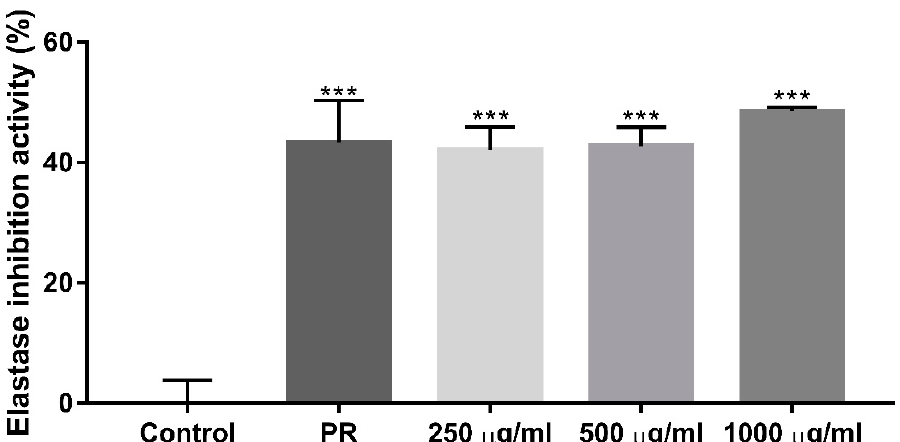
Figure 6. Percentage of elastase inhibition activity according to PR (positive control) and 250, 500, and 1000 μ g/mL of EverCTP TM (NEWTREE Co., Ltd., Seoul, Korea) treatment. The treatment increased elastase inhibition activity as much as PR. *** p < 0.005, independent samples t -test compared with the control. PR, phosphoramidon.